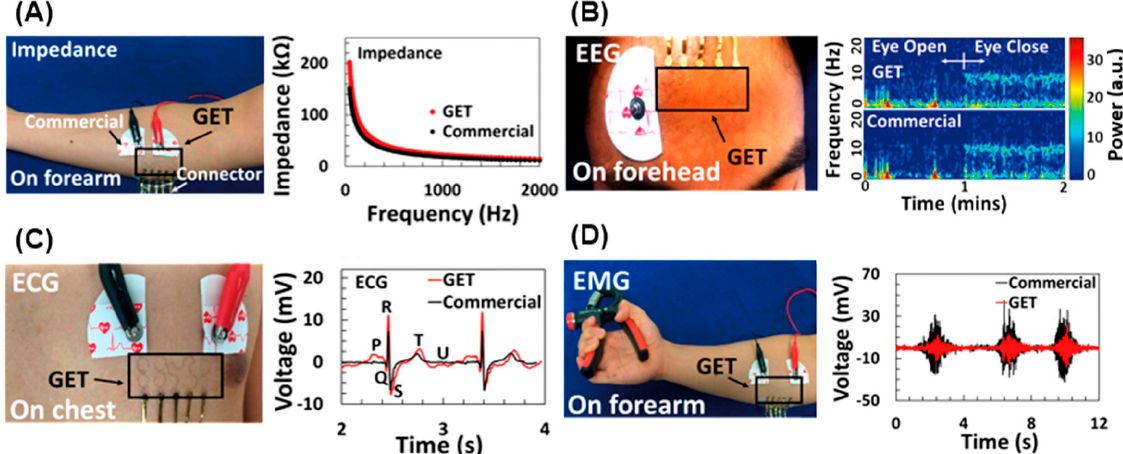
Figure 10. ( A ) Without any skin preparation, the contact impedance between GET and skin is almost identical to that between skin and commercial gel electrodes. ( B ) EEG sensing using both gel and GET electrodes on the forehead (left). Both spectrograms show an α rhythm of 10 Hz when the eyes were closed. ( C ) ECG measurements with synchronized GET and gel electrodes. Both electrodes are capable of measuring characteristic ECG peaks. ( D ) EMG sensing with the GET and gel electrodes on the forearm while the subject squeezed the hand exerciser three times [126]. Reprinted with permission. Copyright (2017) American Chemical Society.